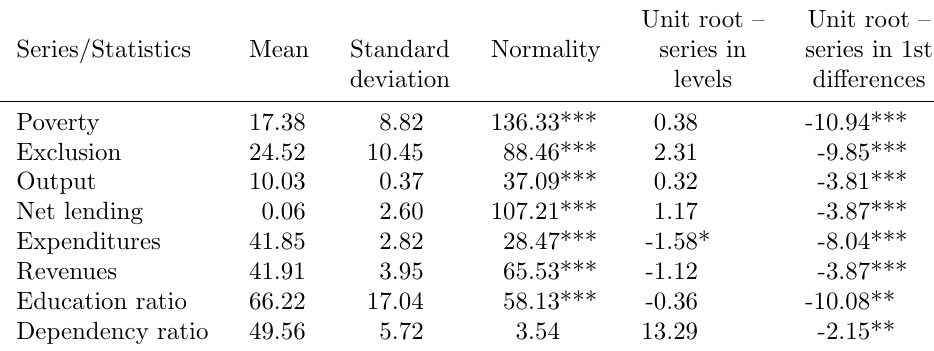
Table 2: Statistical Properties of the Data